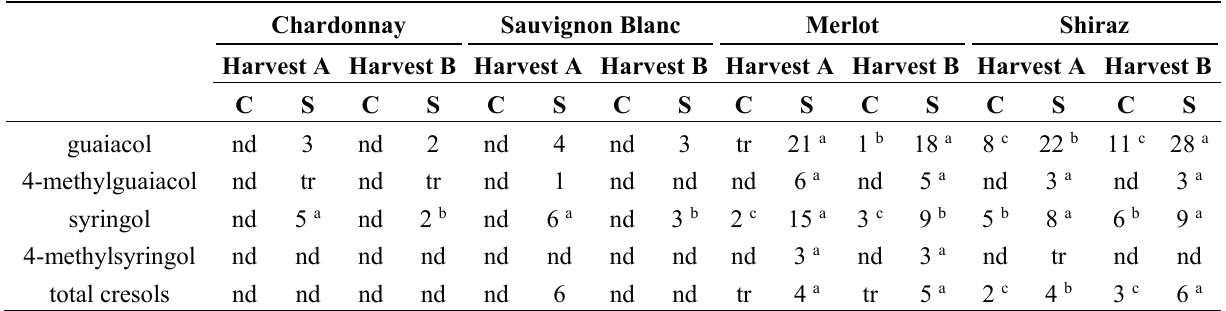
Values represent the mean of three replicates. Values followed by different letters are significantly different (compared within each variety), p < 0.05; nd = not detected; tr = trace ( i.e. , positive identification, but <1 µg/L); C = control; S =